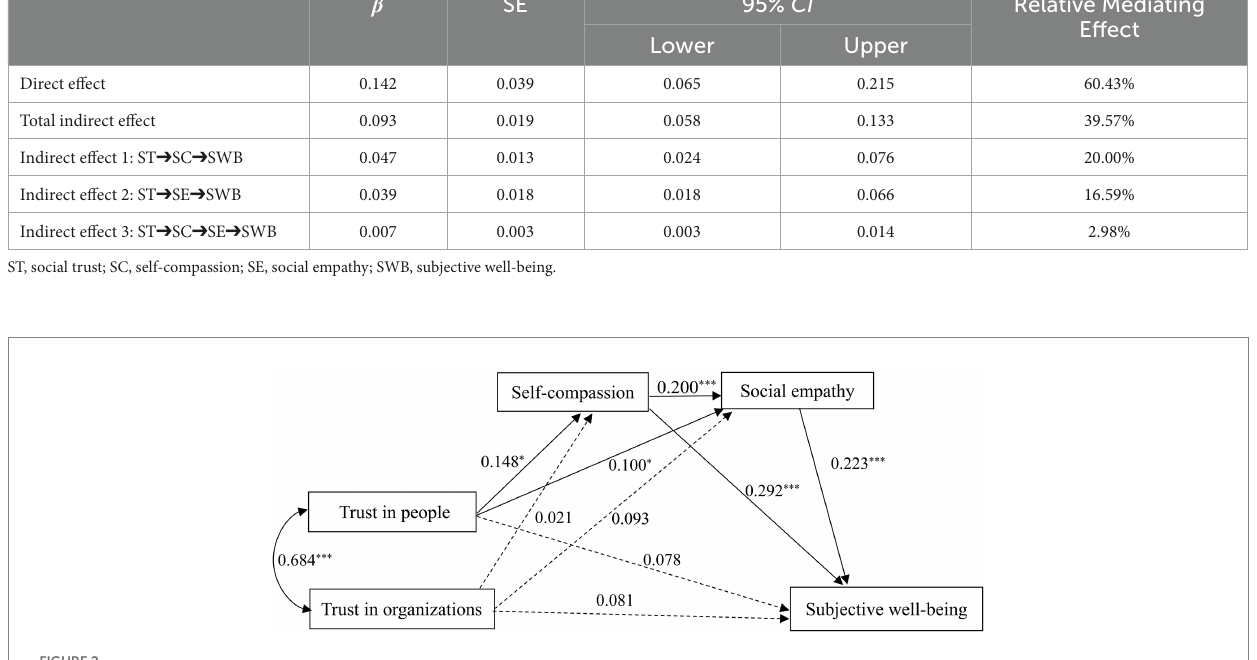
FIGURE 2 Path analysis of social trust in people and organizations, self-compassion, social empathy, and subjective well-being. *** p < 0.001, * p ≤ 0.05.